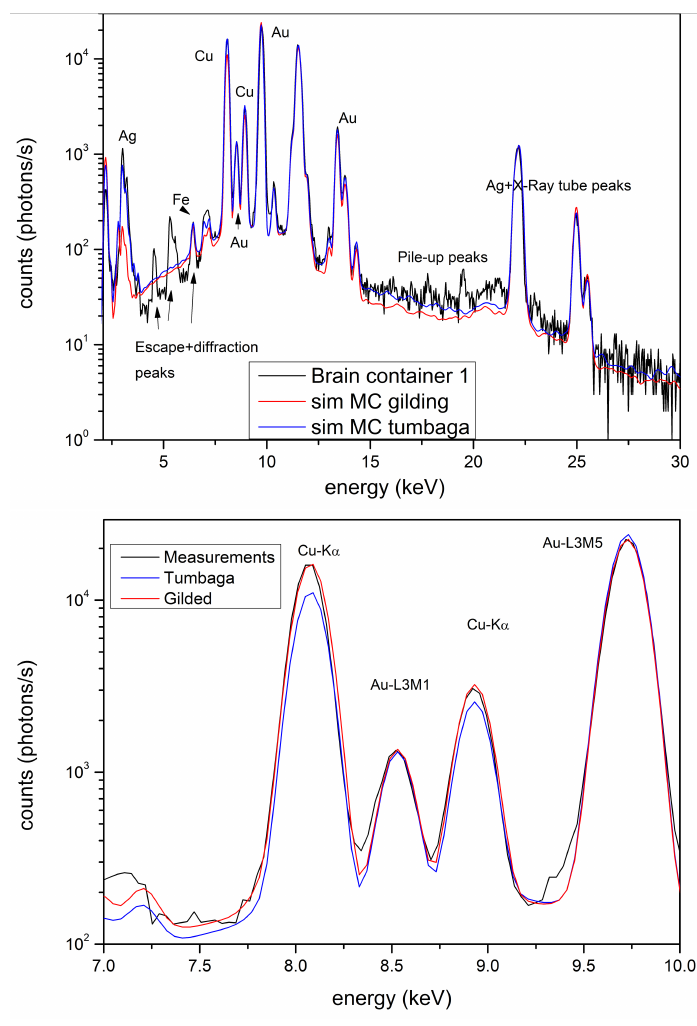
Figure 8. Brain protector. Comparison of the simulated X-ray spectra of gilded copper, Tumbaga and XRF measured spectra. In the figure at the bottom the peak strcture in the 7–10 keV range is depicted. It clearly shows the effect of the different models on the quality of the